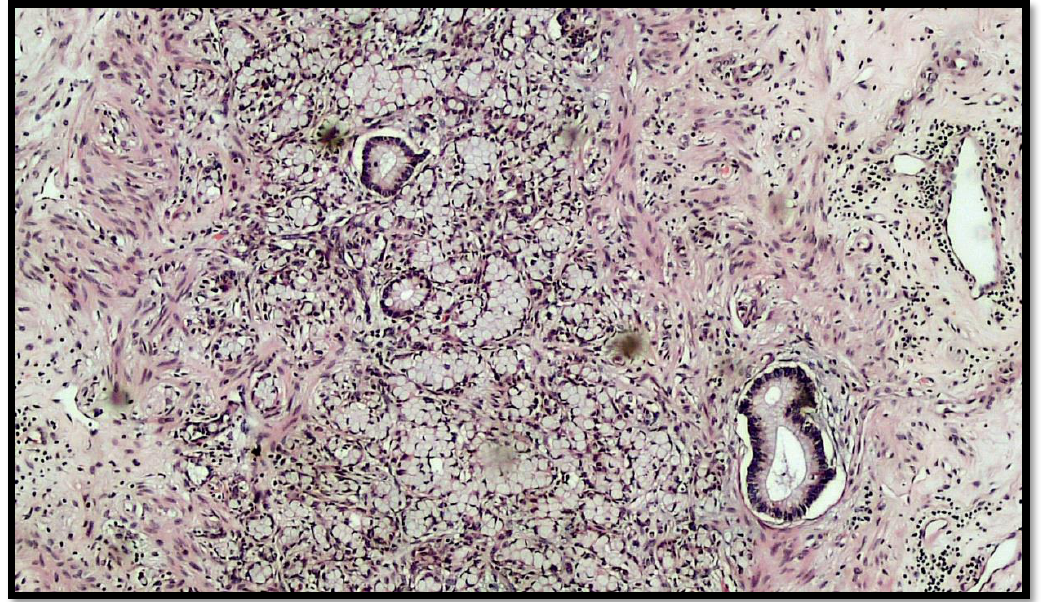
Figure 3. Another photomicrograph showing goblet cell carcinoid and some glands in the muscular wall of the appendix. (Hematoxylin – eosin, original magnification 20×).